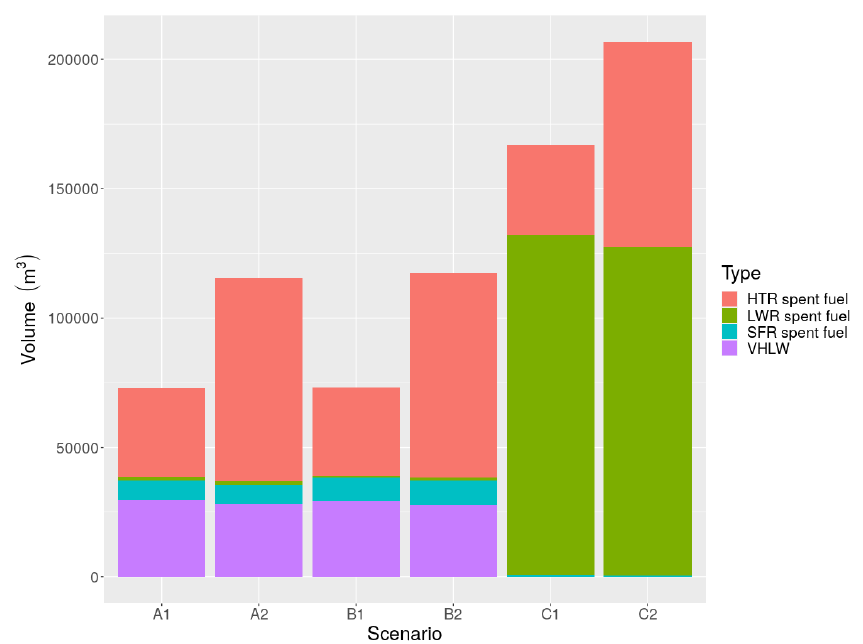
Figure 5. Volumes of spent fuel and Vitrified High Level Waste (VHLW) in year 2255 for the three fuel cycle strategies (A, B and C) and two heat scenarios (1 and 2), which results in six total